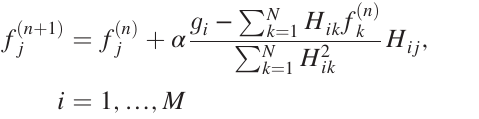
FIG. 5. Schematic diagram of the weight element H forward projection matrix H . H intersection between the wire and the pixels.